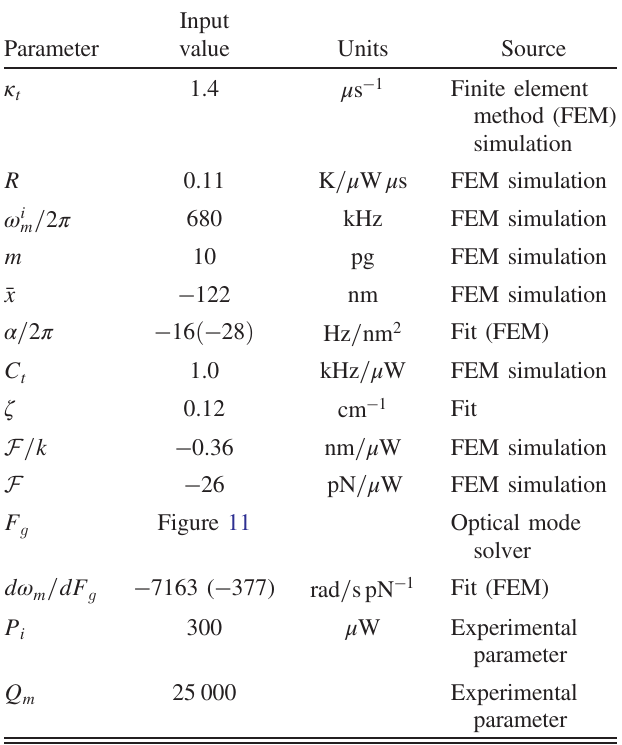
TABLE I. Parameters input to model for γ 0 Values in brackets are predictions from simulations and are included for comparison with values determined from experi- mental fits.